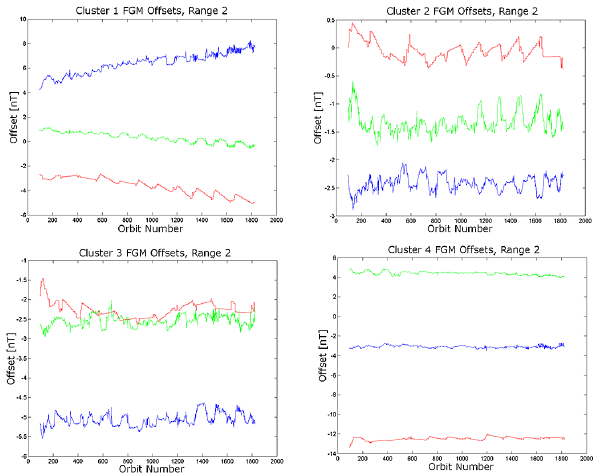
Figure 4. Range 2 spin-axis ( O 1 , red) and spin-plane ( O 2 and O 3 , blue and green) offsets in nanoteslas for orbits 93–1825 (Febru- ary 2001–February 2012).